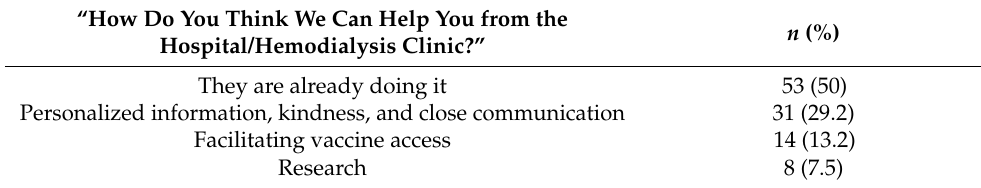
Table 4. Basal descriptive coping resources demanded of the healthcare team (N = 106) results in the total